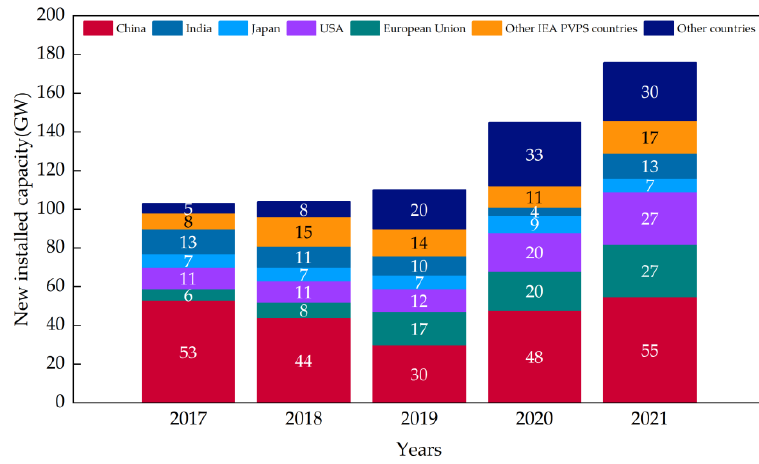
Figure 1. 2017–2021 growth per region.